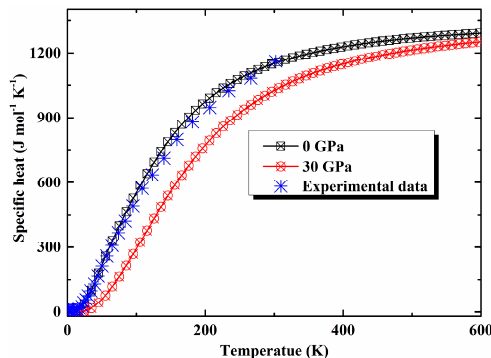
Figure 6. The value of C P of K 8 Si 46 as a function of temperature at 0 and 30 GPa, in comparison with the experimental data [41].